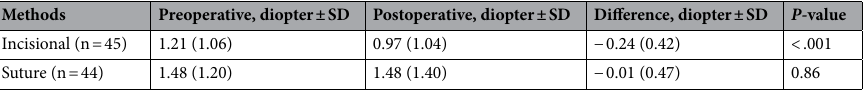
Table 3. Changes in astigmatism at 6-month follow-up after epiblepharon surgery.